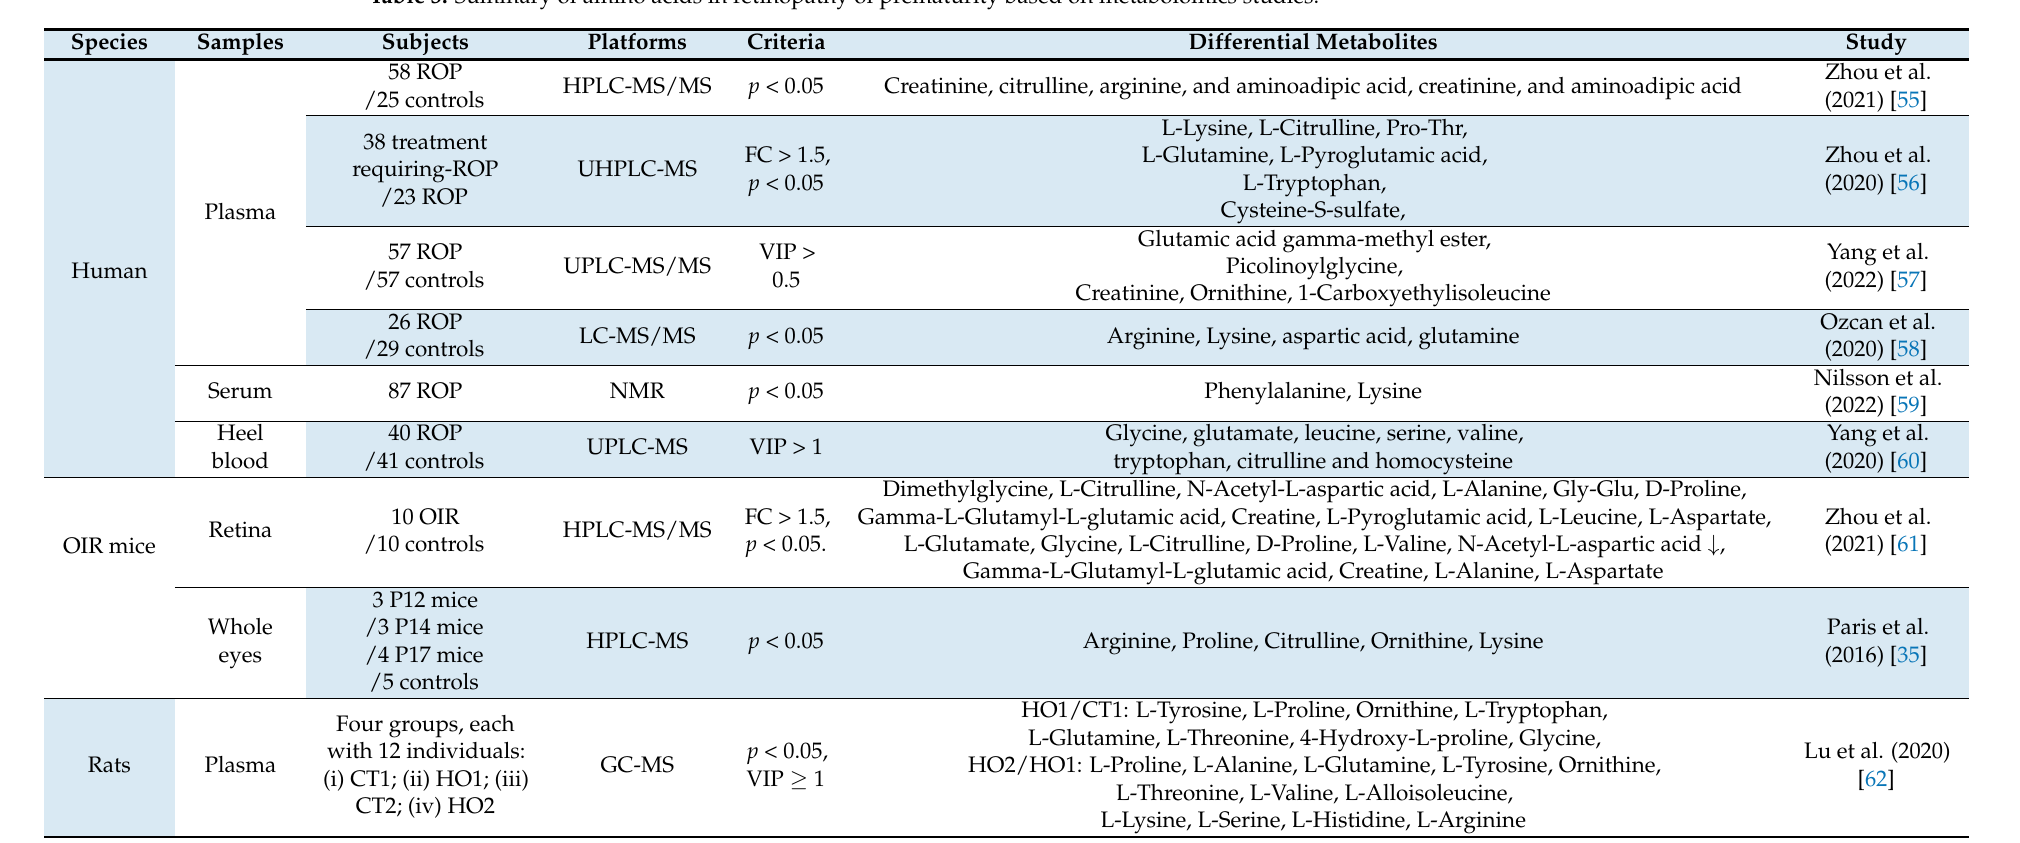
Table 3. Summary of amino acids in retinopathy of prematurity based on metabolomics